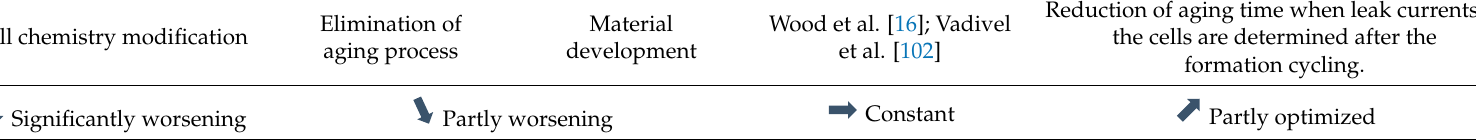
Table 1. Research solution